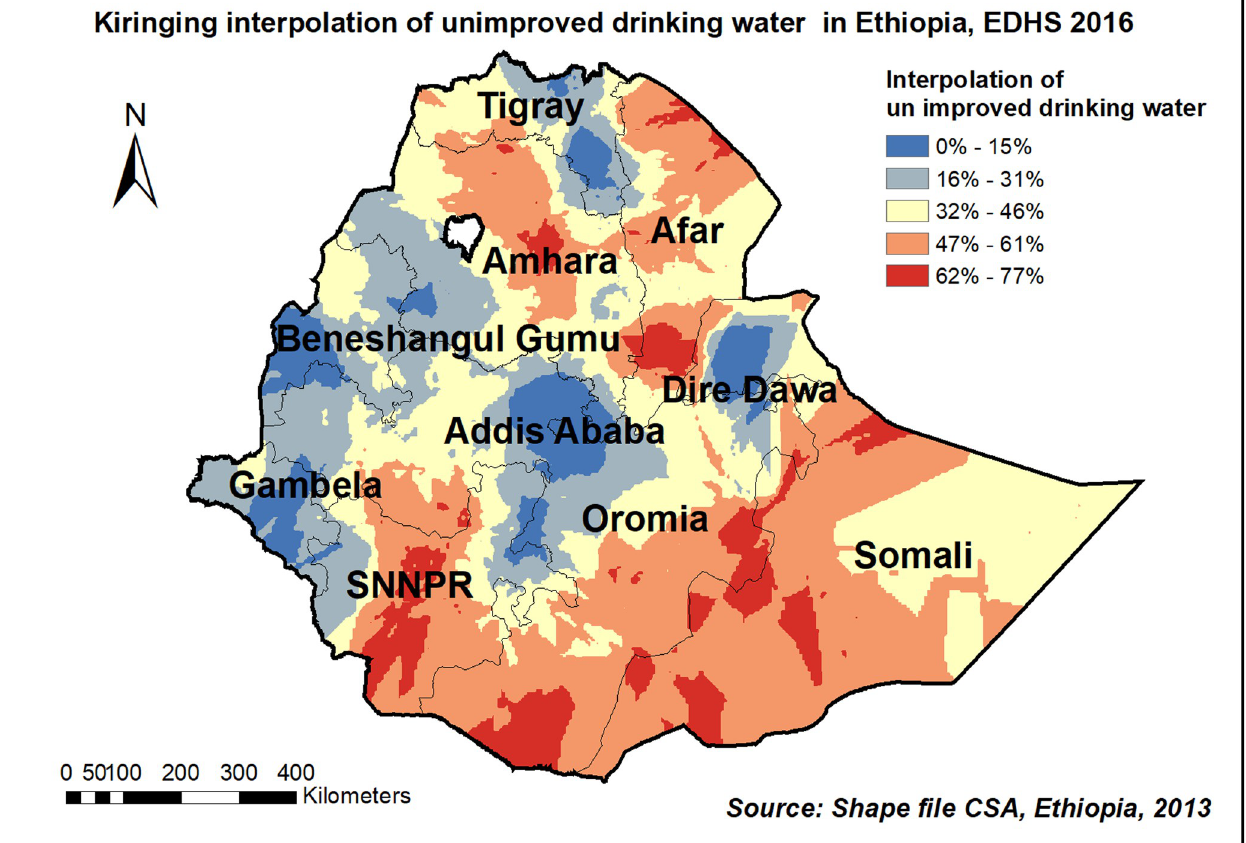
Fig 6. Kiringing interpolation of unimproved drinking water source in Ethiopia, EDHS 2016, shapefile from 2018 GADM and plotted using ArcMap version 10.7 software.